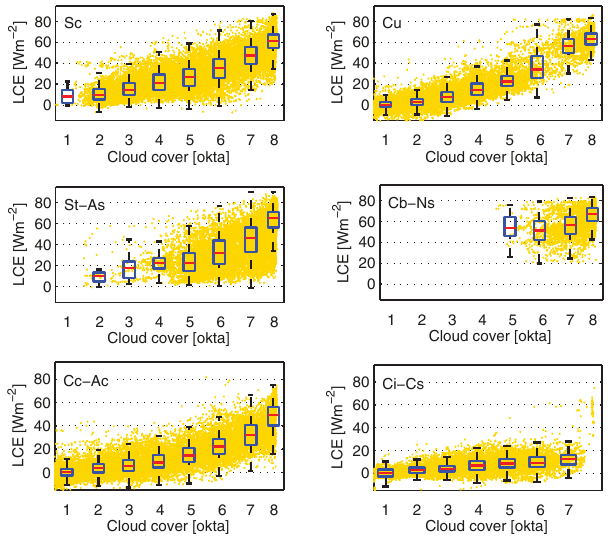
Figure 3. Dependence of the LCE on cloud coverage for Davos for cloud classes stratocumulus (Sc), cumulus (Cu), stratus–altostratus (St–As), cumulonimbus–nimbostratus (Cb–Ns), cirrocumulus–altocumulus (Cc–Ac) and cirrus–cirrostratus (Ci– Cs). Data points (yellow dots) and box plots per okta with median (red line), interquartile range (blue box) and spread without